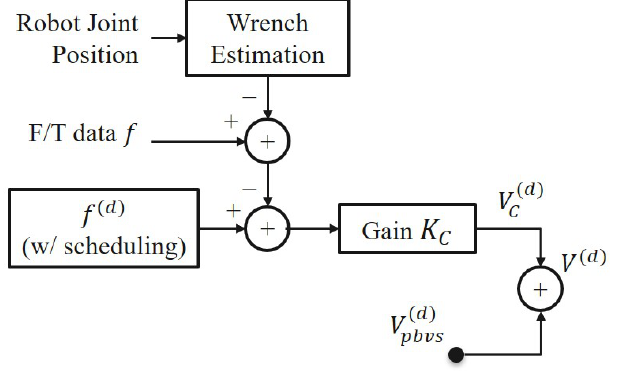
( d ) Figure 3. The vision-based velocity command V is combined with the force accommodation velocity pbvs ( d ) command V to generate the overall velocity command V ( d ) for the robot end effector. The force C accommodation control is a generalized damper with the estimated panel gravity load removed fromthe measured force and